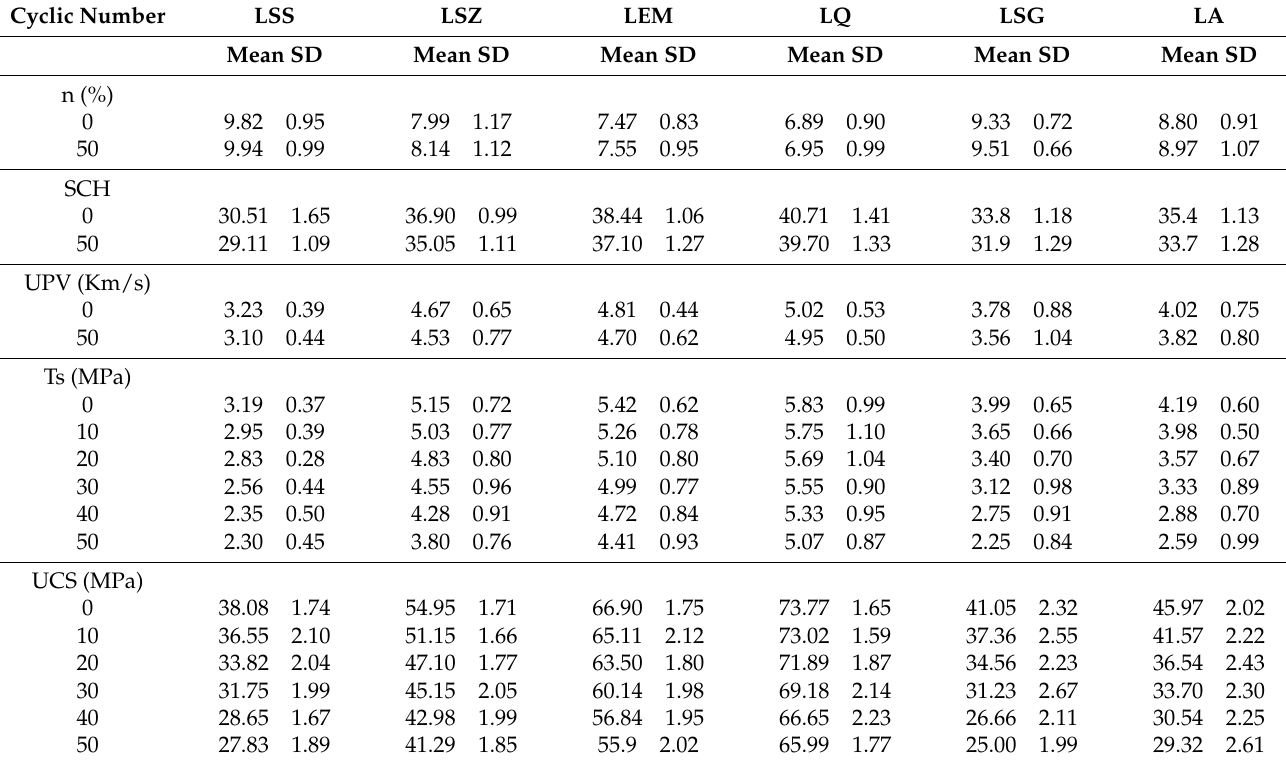
Table 4. Mean values and standard deviations of the physico-mechanical properties under cyclic thermal